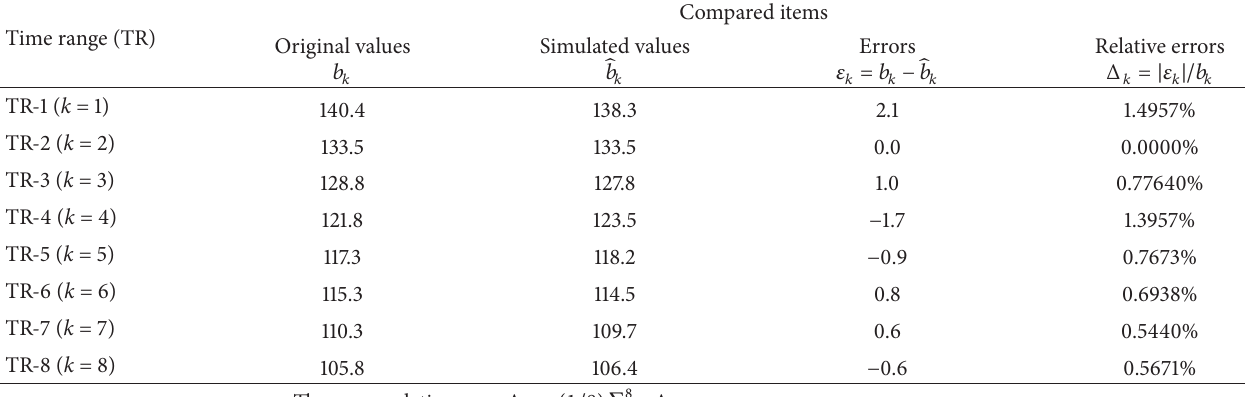
Table 3: Simulated values and errors of lower limits.